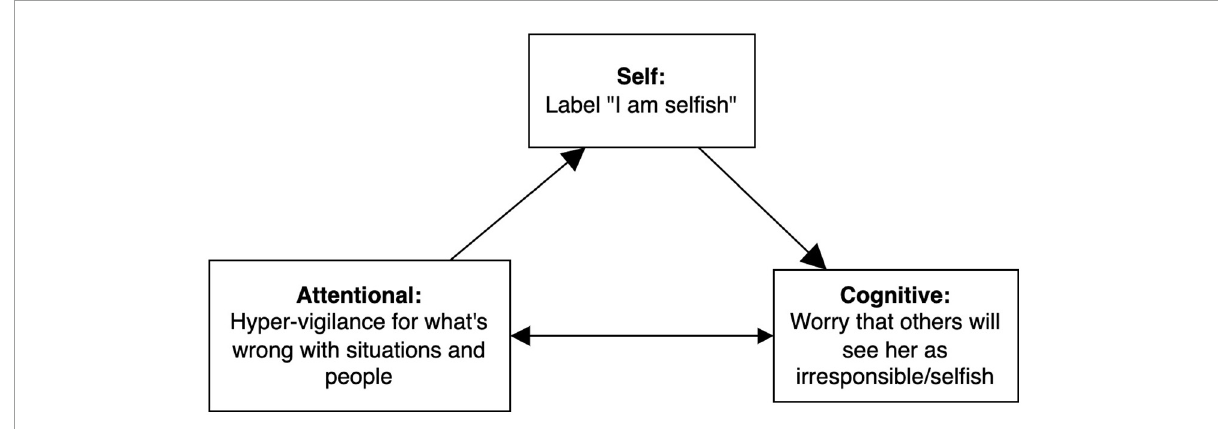
FIGURE3 Self-amplifying loop from Amy’s broader case conceptualization. EEMM dimensions represented by each node are bolded. Size of the arrowheads indicates hypothesized strength of the relationship (bigger arrowheads = stronger